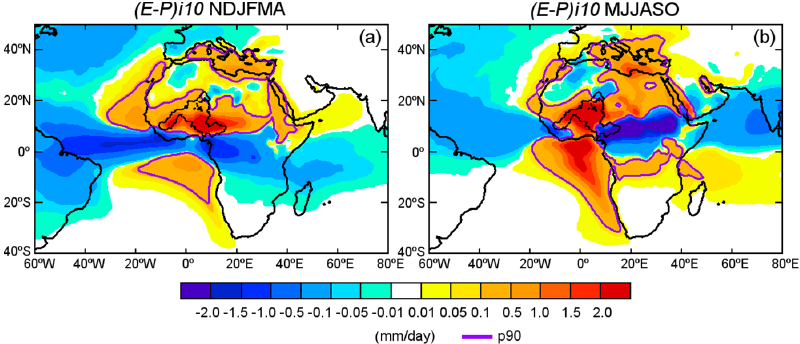
Figure 4. Average pattern of (E – P) backward results integrated from the Niger River Basin for all 10 days for the dry ( a ) and wet season ( b ). The magenta line represents the 90th percentile of the (E – P)i10 > 0 values: (a) p90 = 0.13 mm/day, and (b) p90 = 0.10 mm/day.